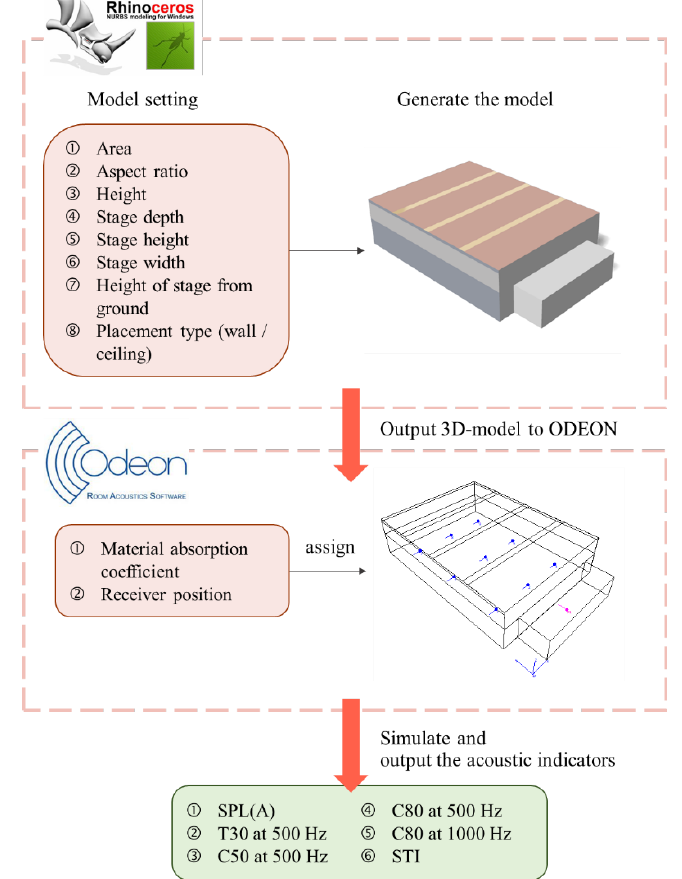
Figure 4. Process of data generation.